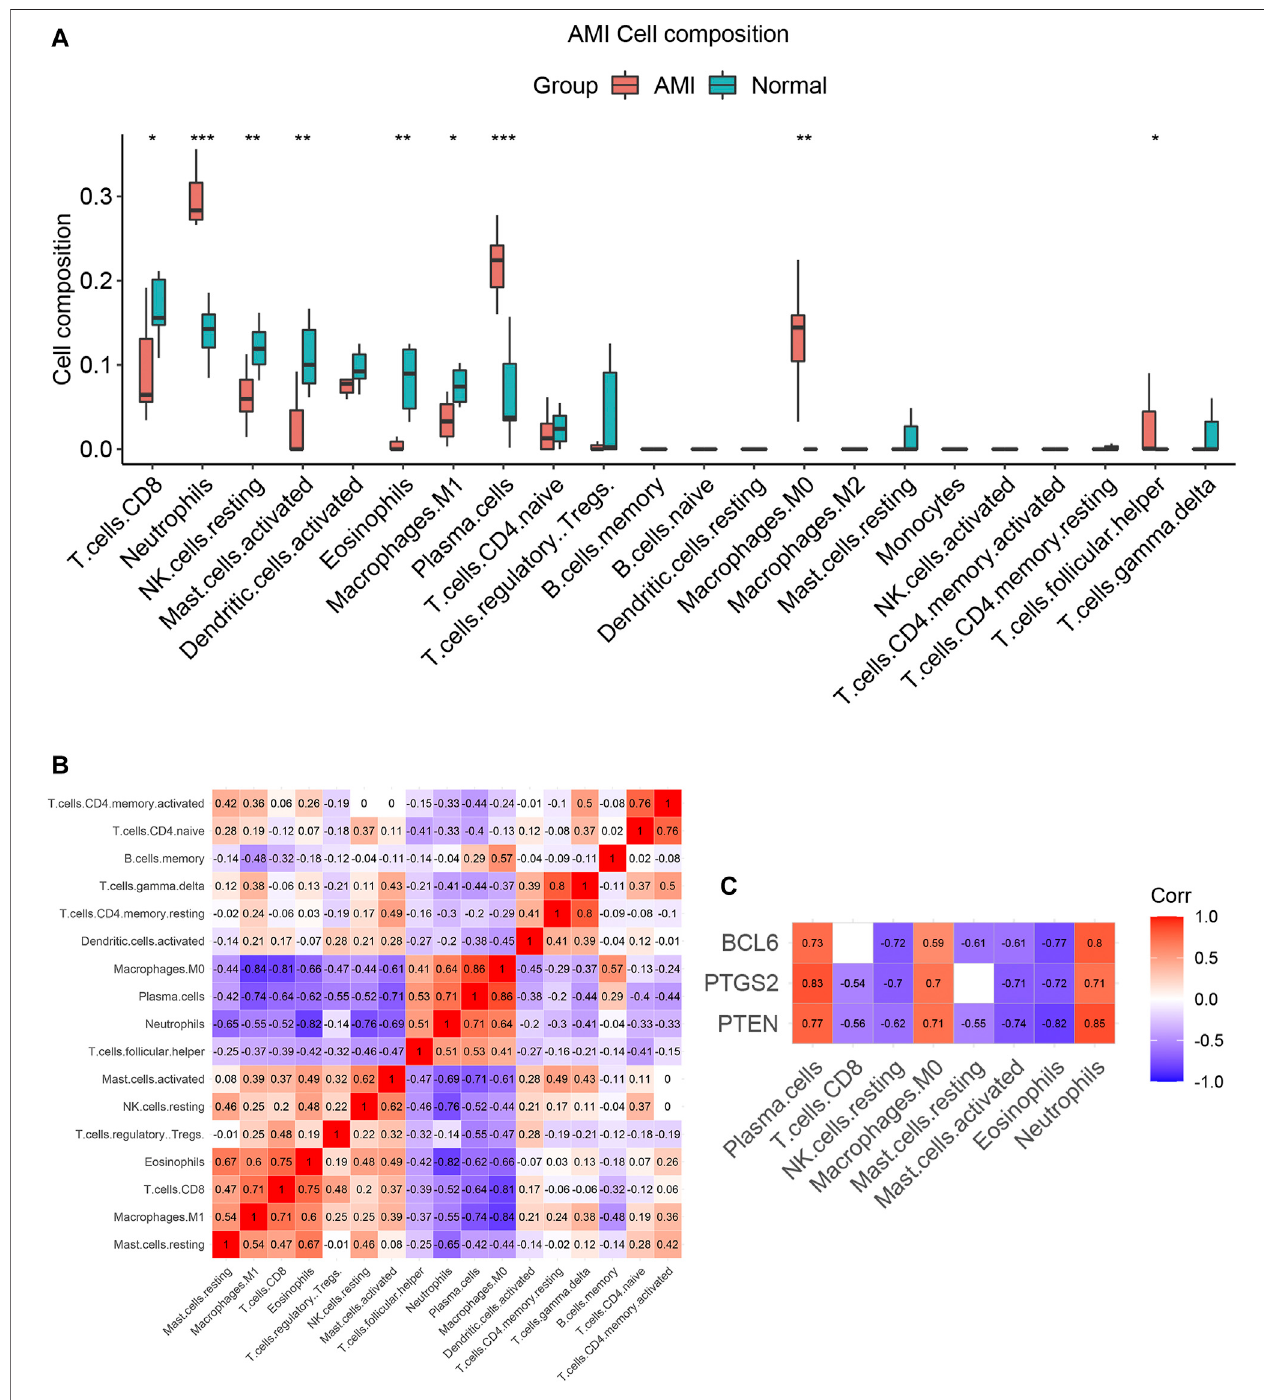
FIGURE 10 | The immune cell in fi ltration patterns in AMI. (A) Pattern of immune cell in fi ltration in AMI. The proportions of neutrophils, plasma cells, follicular helper TcellsandM0macrophagesweresigni fi cantlyincreased,whiletheproportionsofCD8 + Tcells,NKcells,mastcells,eosinophilsandM1macrophagesweresigni fi cantly decreased. (B) The correlation analysis between immune cells. (C) Correlation analysis between expression levels ofPTEN, PTGS2, BCL6 and immune cells. * p < 0.05; ** p < 0.01; *** p < 0.001.